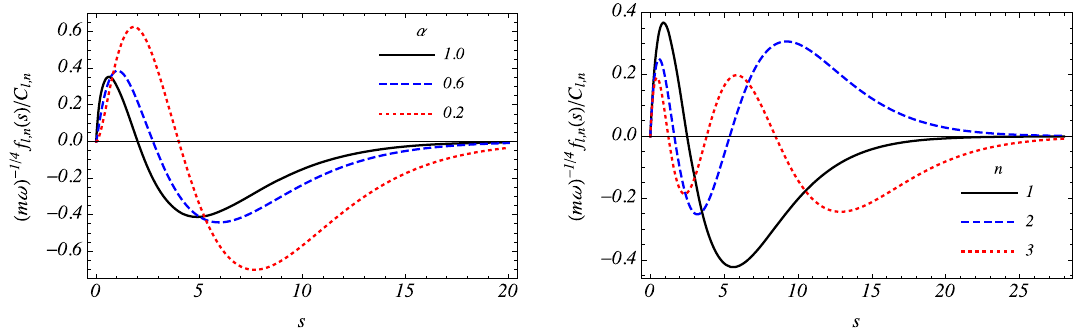
Fig. 2 Profile of the eigenfunction f l , n ( s ) as function of the coordinate s . In the left plot, we consider different values of the parameter α and n = 1. In the right plot, we have α = 0 . 5, and different energy levels. In both plots we consider κ = 1 / 2